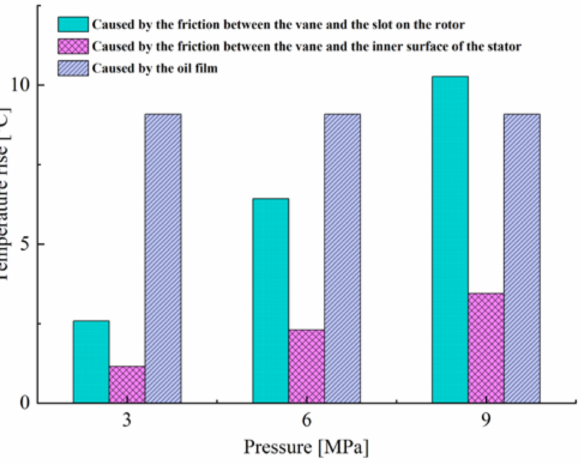
Figure 13. Comparison of temperature rise caused by frictional heat generation in the three parts of the oil discharge